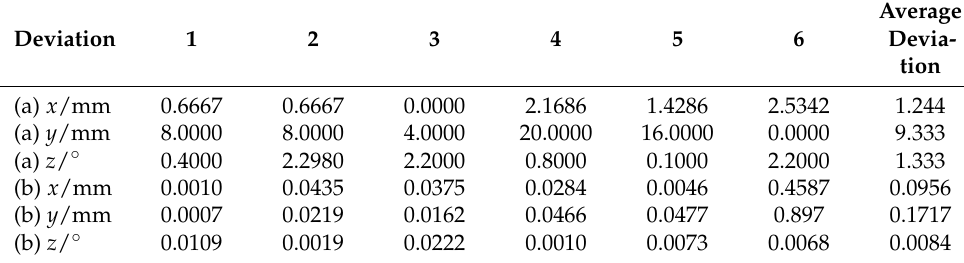
Table 3. Degree of deviation of three direction x , y , z : (a) the rotation axis invariance method deviation